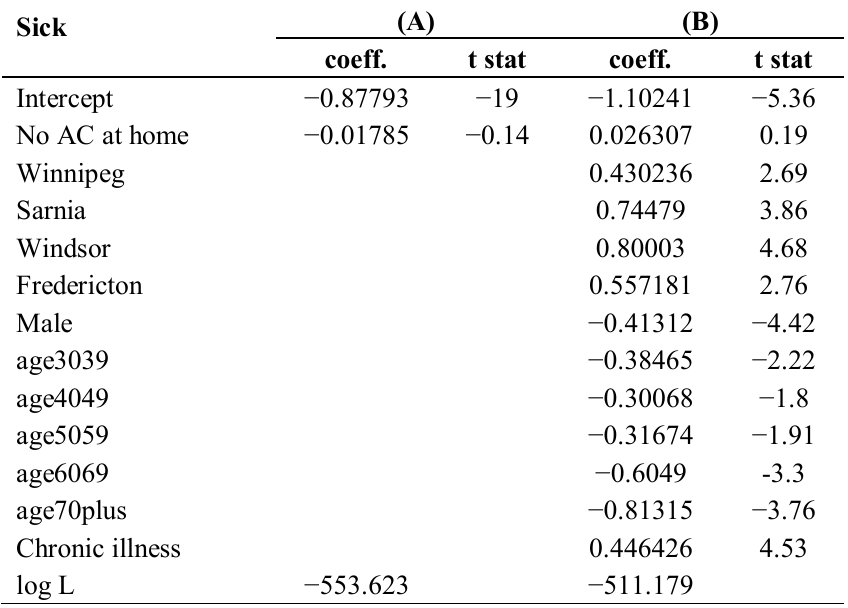
Table 14. Probit regressions. Dep. Var. = Having had a heat-related illness during the most recent heat spell